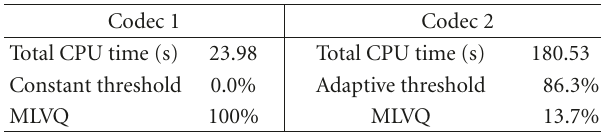
Table 2: Computational complexity based on grey Lena of 256 × 256 (8 bit) at bit rate